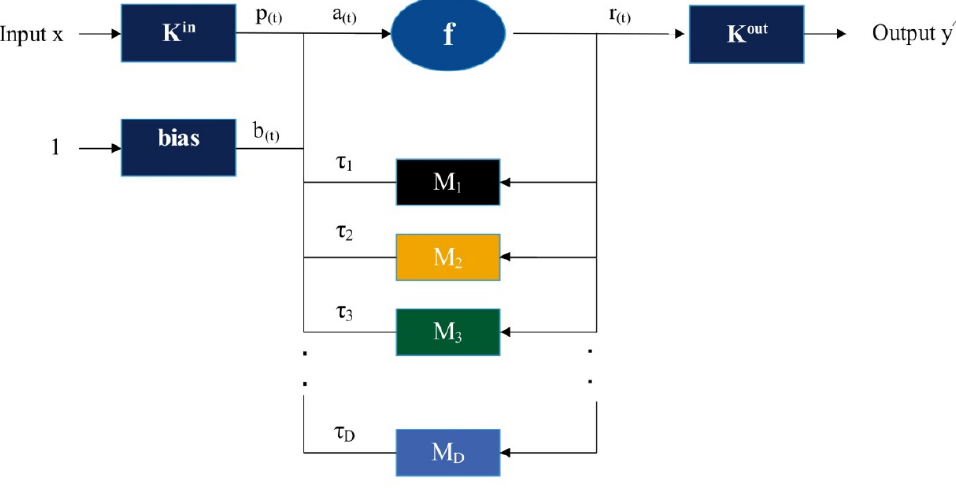
Figure 5. Deep neural network structure.